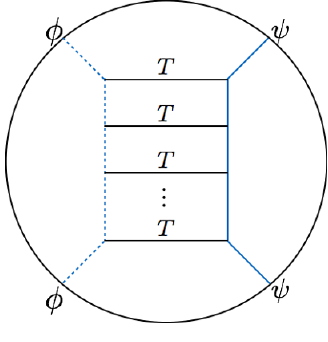
Figure 5 . Ladder diagram for graviton exchange in